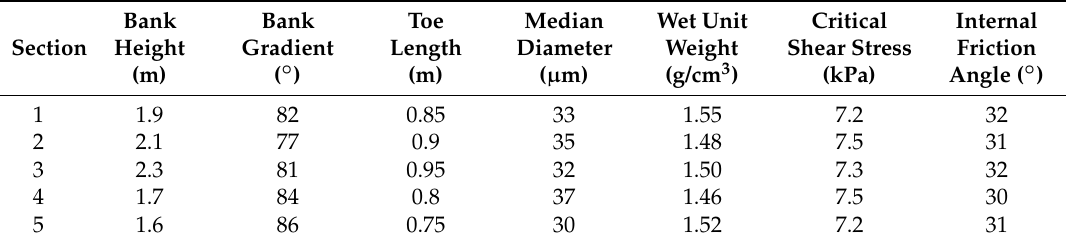
Table 4. Characteristics of the sections selected for this